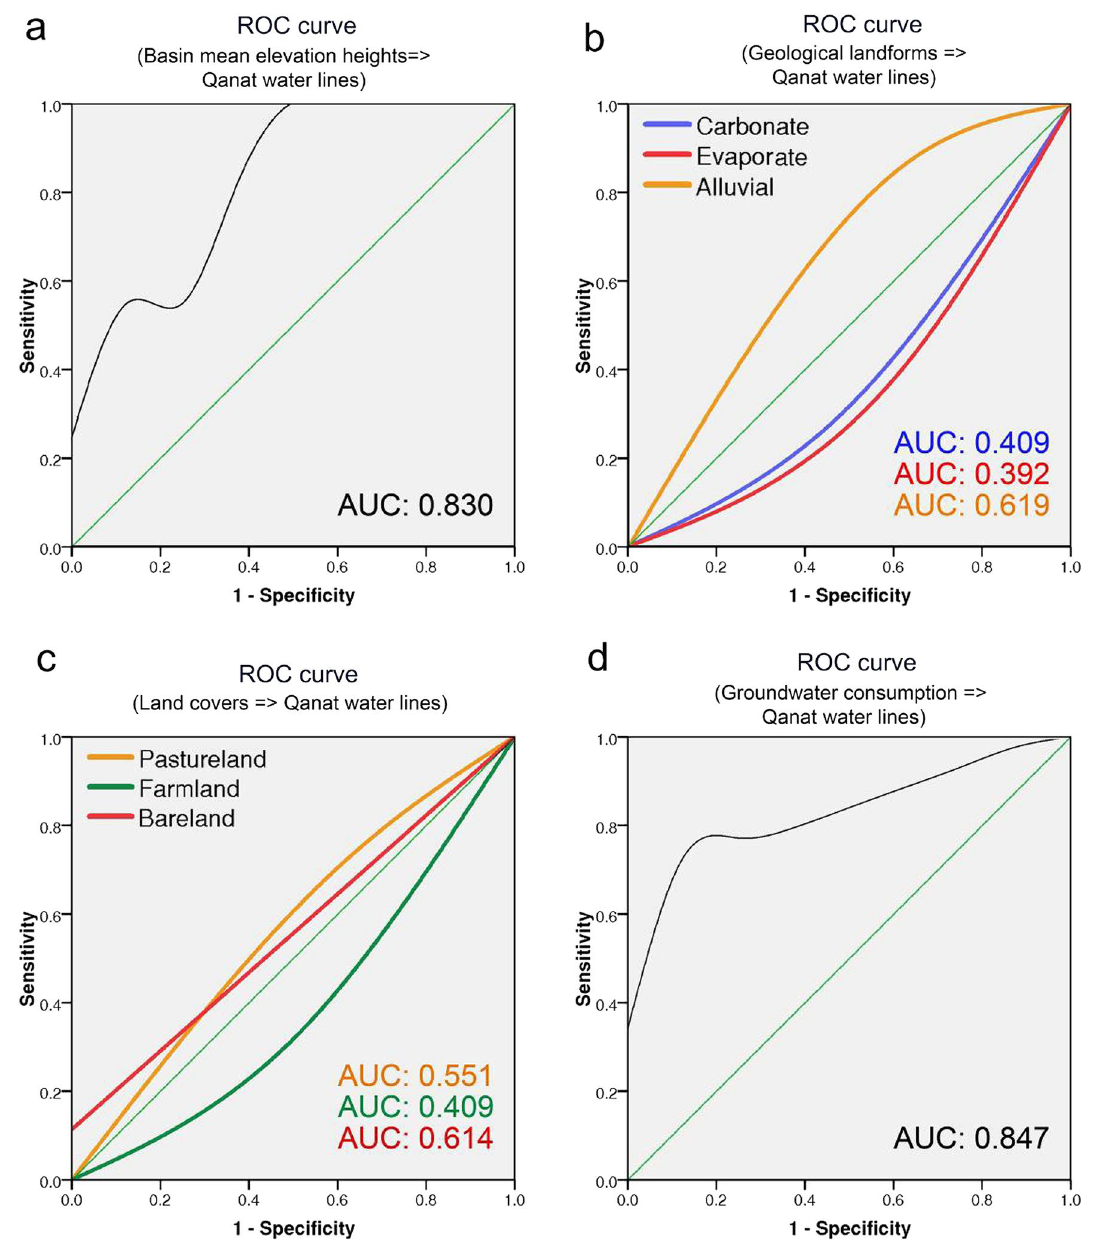
Fig. 5 ROC plots to sensitivity analysis between Qanat water lines and some selected variables a . mean elevation heights, b . geological land- forms, c . t land covers, and d . groundwater consumption for agricultural